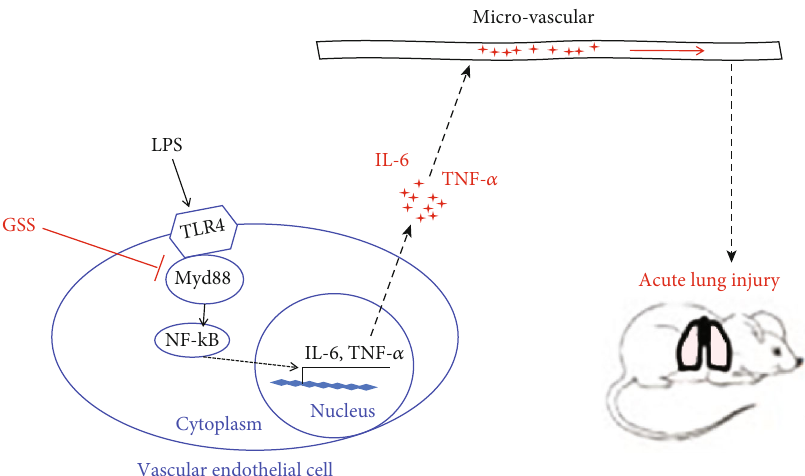
Figure 9: Schematic fi gure of possible signaling mechanisms of GSS in the inhibition of LPS-induced lung vascular endothelial cell in fl ammatory response and subsequent ALI in